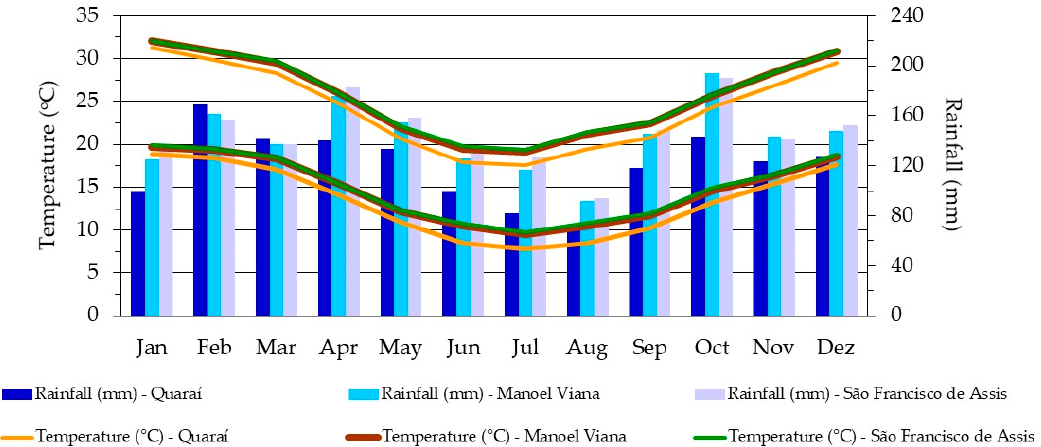
Figure 2. Mean monthly rainfall and temperature for the period 1981–2010. Climatological mean based on 30 years of data (1981–2010), using official INMET stations, and later interpolating for locations that do not have a meteorological data measurement station. Source: [14].